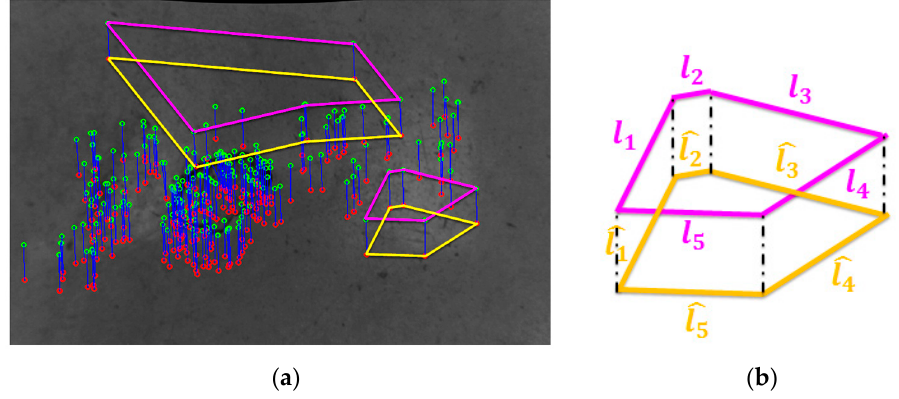
Figure 7. ( a ) Some polylines having five sides are built by using the target and the source keypoints. ( b ) Enlargement of polylines in relation with each other, whose edge lengths have to be evaluated for establishing the goodness and robustness of keypoints in terms of image locations.